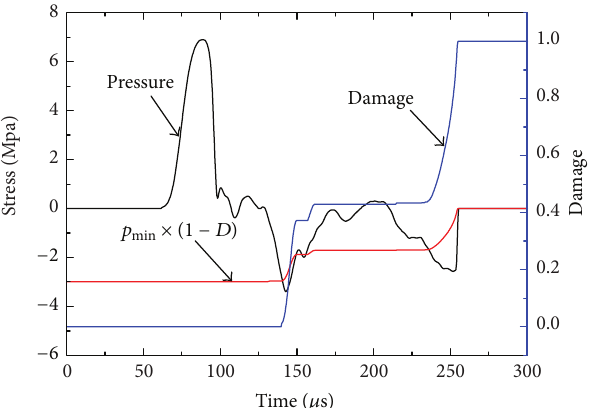
Figure 8: Equivalent stress, failure stress, and damage versus time of target